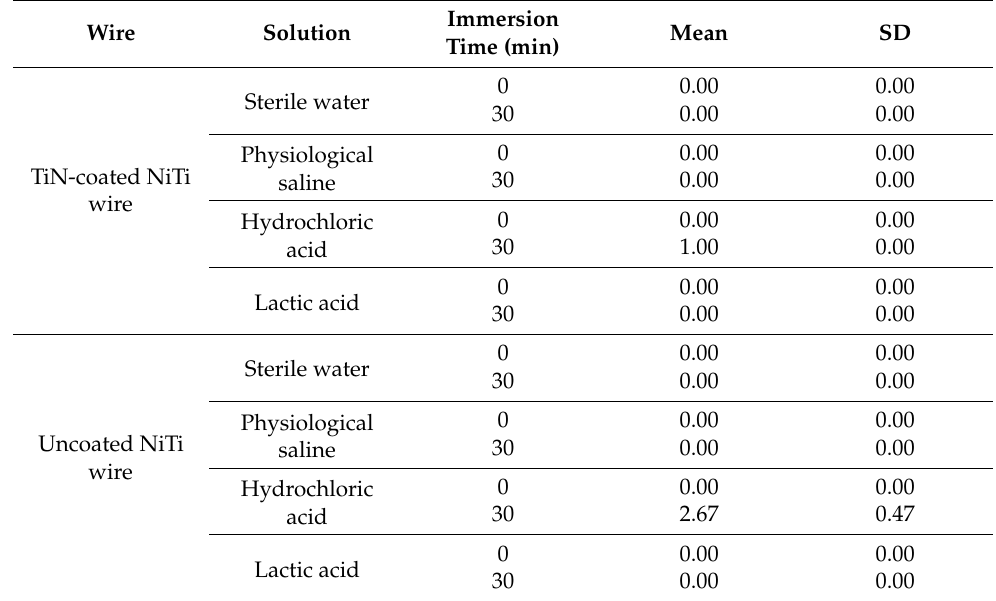
Table 4. DMG test results for NiTi wire.